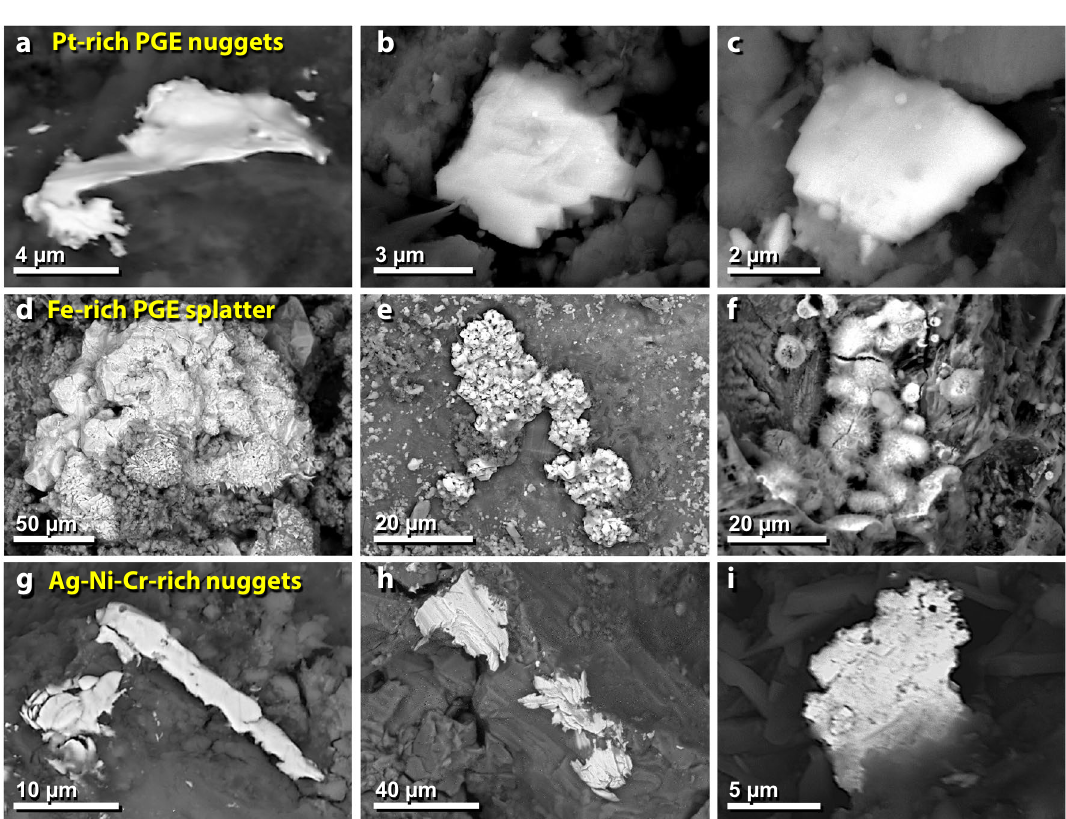
Figure 34. SEM images of nuggets of melted metals in mudbrick meltglass from the palace. ( a )–( c ) Pt-dominant TeH nuggets enriched in ruthenium (Ru), rhodium (Rh), palladium (Pd), osmium (Os), iridium (Ir), and platinum (Pt). ( d )–( f ) Fe-dominant TeH splatter is also enriched in PGEs. ( g )–( i ) Nuggets enriched in varying percentages and combinations of nickel (Ni), chromium (Cr), copper (Cu), and silver